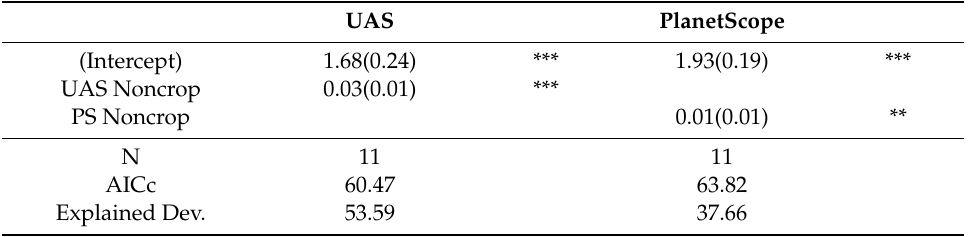
Table 2. GLM results indicating highly significant relationship between noncrop proportion and vocalizing bird richness for both UAS and PS landscape maps. Standard error is reported in parentheses.